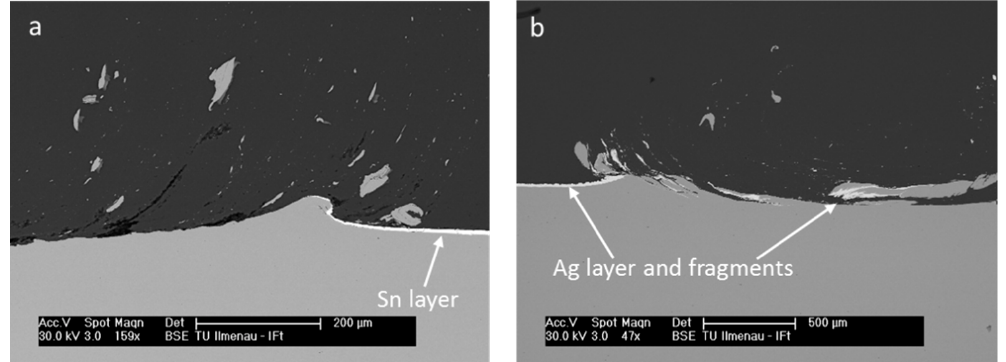
Figure 9. Displacement of the interface plating at 2.2 mm pin length at the boundary of the stirring area: ( a ) Sn; ( b ) Ag.